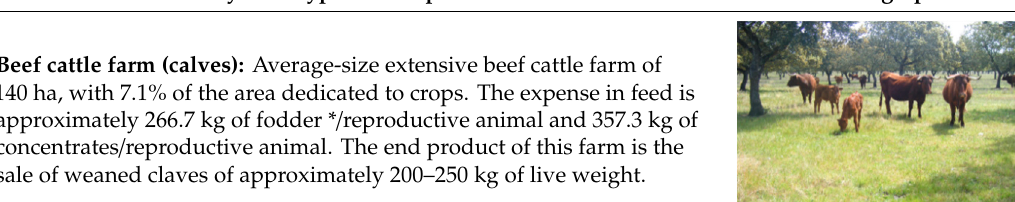
Table 1. Main features of the production systems included in the case study.